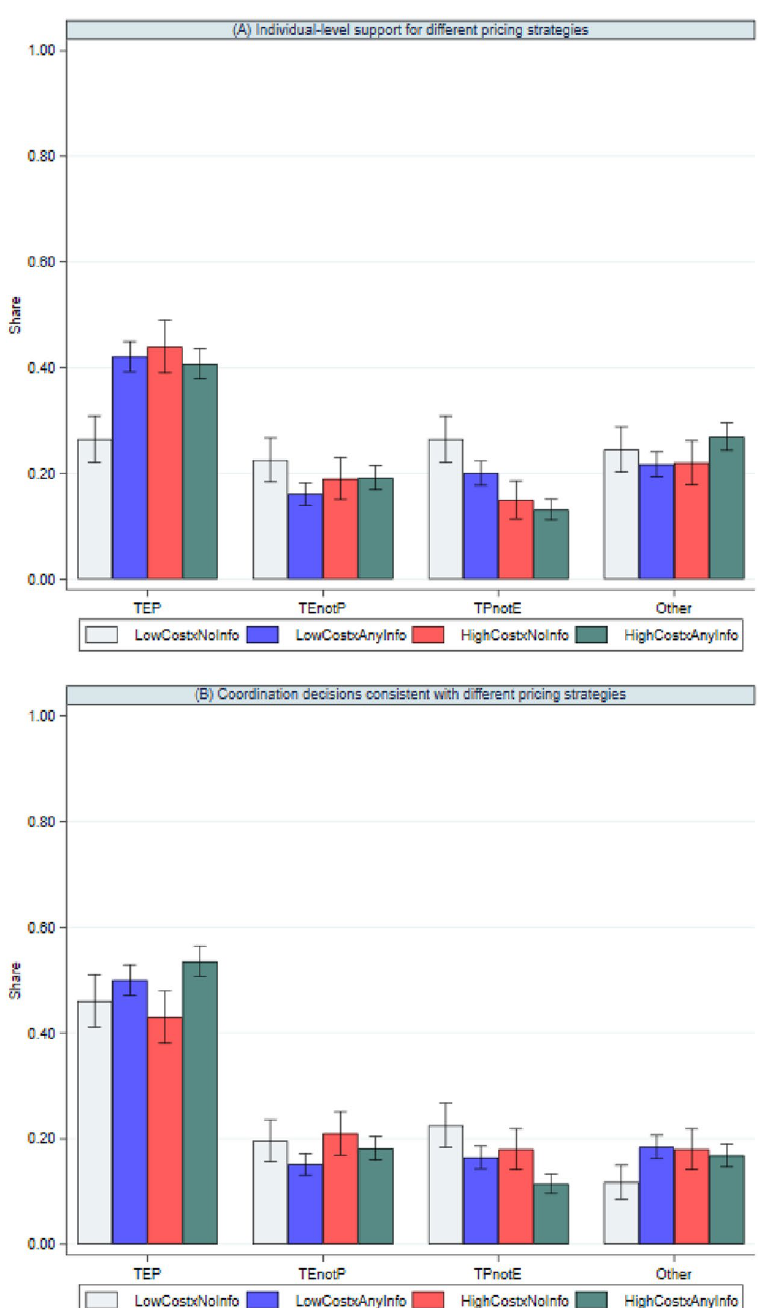
Figure 1. Support for different pricing strategies by vaccine cost and information. Notes : Data from all three information conditions—Arguments, Facts, and Arguments + Facts—were pooled into a single “AnyInfo” condition. TEP refers to a pricing strategy that is tiered across countries, equitable for poorer countries, and profitable for manufacturers. TEnotP refers to a tiered pricing strategy that is equitable but not